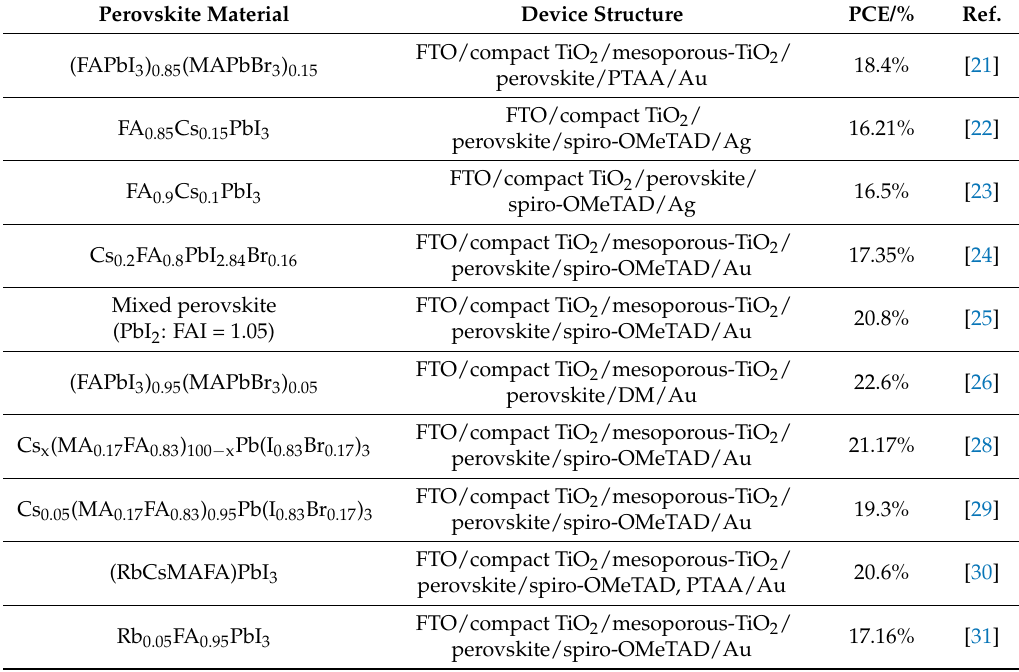
Table 1. Summary of researches about improving the power conversion efficiency (PCE) of PSC by optimizing chemical